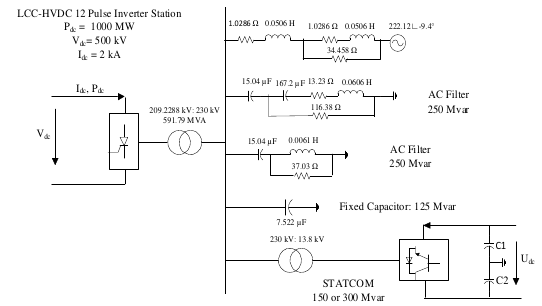
Fig.1: LCC-HVDC Inverter Station with Reactive Power Compensators, connected to Weak AC